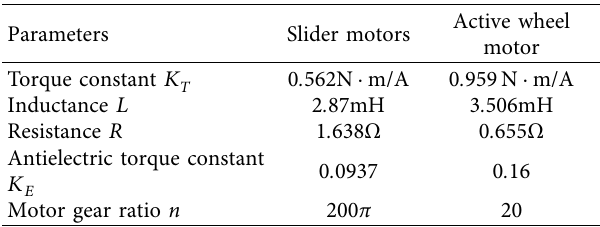
Table 2: The motor parameters for